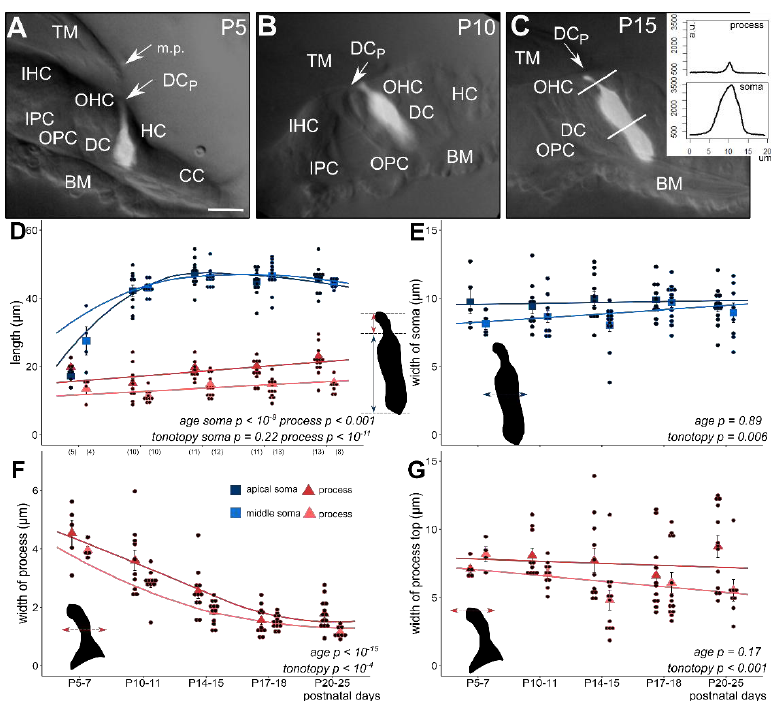
Figure 1. Morphometric changes of the soma and the phalangeal process of apical and middle turn Deiters’ cells during postnatal development (P5–25). The subcellular compartments (soma and phalangeal process) were visualized by single-cell electroporation loading of a fluorescent Ca 2+ indicator (OGB-1) in the BALB/c mouse hemicochlea. Image of fluorescent cells was overlaid on the respective widefield image illuminated obliquely ( A – C , all in middle turn). Plot of fluorescence intensities along a line profile was used to measure the appropriate cell dimensions (inset in C ). In P5–7 mice the tunnel of Corti is not opened yet and the marginal pillars can be seen over the third row of Deiters’ cell ( A , P5). The cell shape differs totally from the one of the older Deiters’ cells ( B , P10 and C , P15). From P10 the tunnel of Corti is opened ( B , C ). At this developmental stage the soma elongated significantly, nearly to the adult level ( D ; apical, dark blue square; middle, light blue square). The maturation-dependent elongation of the phalangeal process was gradual and showed tonotopic difference between the apical and middle cochlear turn ( D ; apical, dark red triangle; middle, light red triangle). Contrary to the elongation in length, the width of the phalangeal processes decreased gradually by maturation during the P5–25 period and also showed a tonotopic difference, apical turn processes being wider ( F ). Width of the soma ( E ) and of the head plate of the phalangeal process ( G ) did not change significantly during the development, but the turn differences were present in both parameters, i.e., cells in the apical turn showed the wider soma and head plate in all ages compared to middle turn Deiters’ cells. The width of the subcellular compartments was measured at their half-length. Square and triangle symbols show mean ± SEM and the black dots indicate the individual measurements. Number of experiments are in parenthesis ( D ) and they are the same for the appropriate variables in E–G. Respective p values, showing the significance of age or tonotopy are written in italics. Details of statistical analysis are given in the Materials and Methods. The scale bar represents 15 µm. TM: tectorial membrane; BM: basal membrane; IHC: inner hair cell; OHC: outer hair cell; IPC: inner pillar cell; OPC: outer pillar cell; DC: soma of Deiters’ cell; DCp: process of Deiters’ cell; HC: Hensen’s cell; CC: Claudius’ cell; m.p.: marginal pillar.